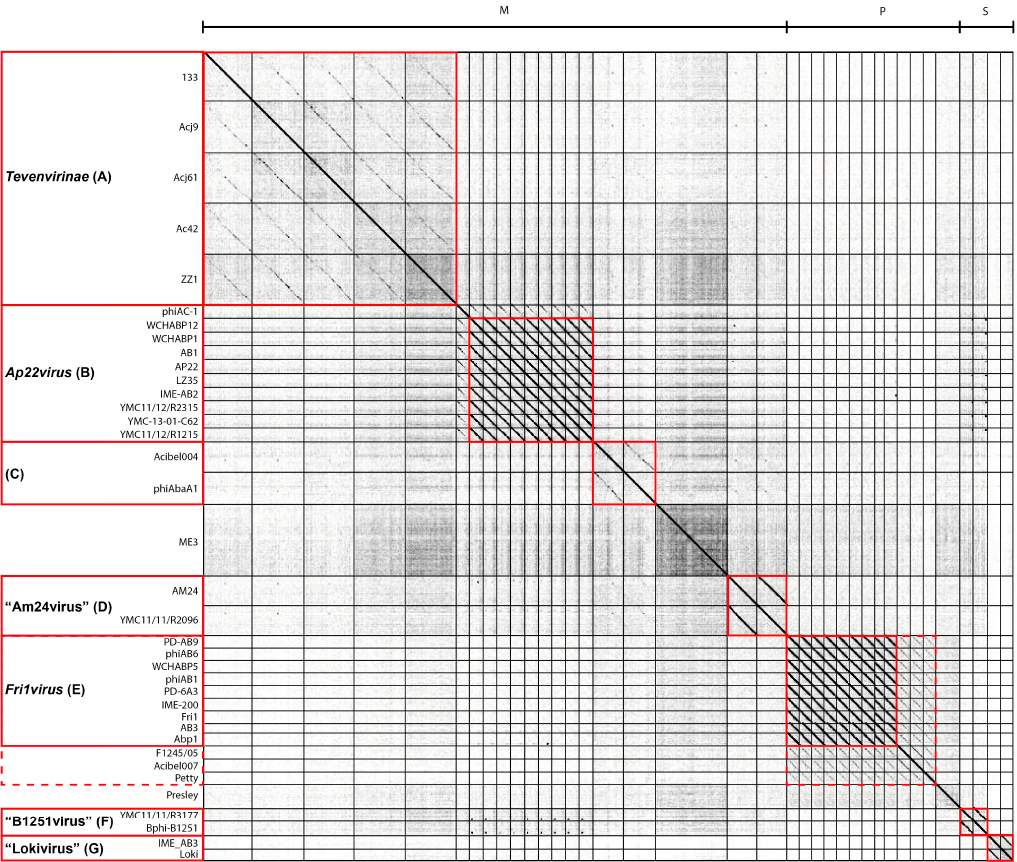
Figure 1. Dot plot alignment of nucleotide sequences from 37 Acinetobacter phage genomes. A FASTA file was constructed by concatenating all 37 Acinetobacter phage genomes. Where necessary, genomes were reverse complemented and/or colinearized. The 2,655,181 bp file was compared to itself using Genome Pair Rapid Dotter (GEPARD) [36]. Black diagonal lines parallel to the main diagonal indicate strong and continuous sequence similarity while grey lines indicate weaker sequence relationships due to interruptions that result in a discontinuous line. Vertical and horizontal lines were added to indicate individual phage genomes and red boxes to illustrate the assignment of clusters. The dashed red box denotes Acinetobacter phages belonging to the podovirus subfamily Autographivirinae . The phage family is shown on the horizontal axis (M, Myoviridae ; P, Podoviridae ; S, Siphoviridae ) and the name of each phage is denoted on the vertical axis. Clusters corresponding to existing ICTV taxons and newly proposed genera are labelled.